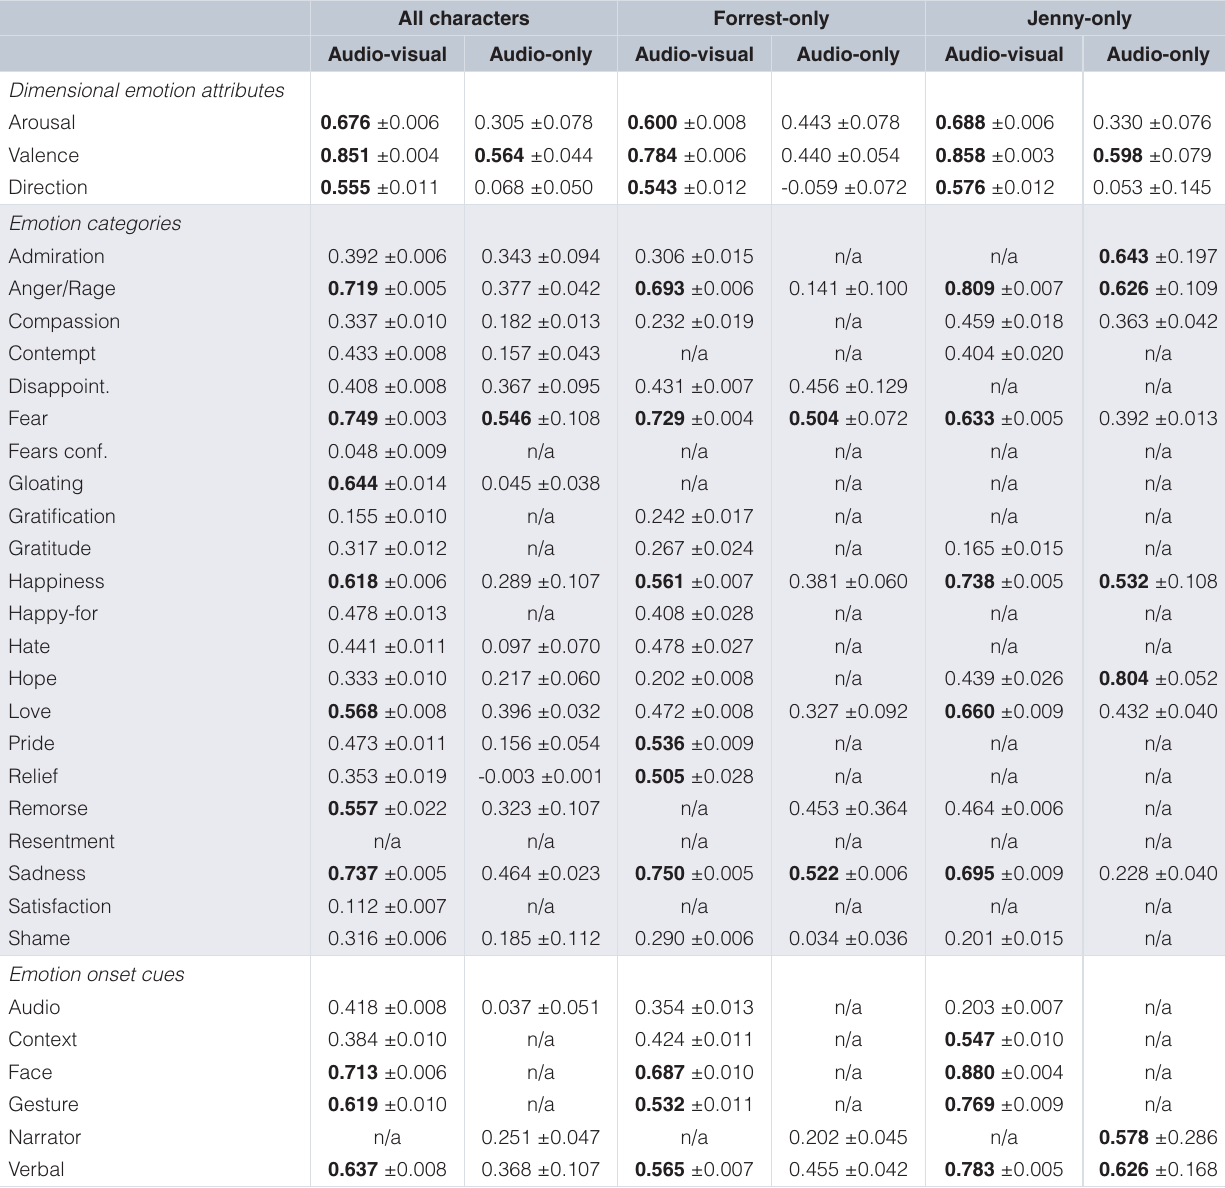
Table 5. Intra-stimulus inter-observer consistency. All values are Spearman correlations for 1 Hz modulations of the fraction of IOA (as, for example, depicted in figure 3) with respect to a particular emotion attribute across the entire duration of the movie. The specified range corresponds to the width of the 95% confidence interval of the mean correlation for all possible combinations of partitioning observers into two sub-groups (audio-visual 4 vs. 5; audio-only 1 vs. 2). Higher correlations indicate higher consistency of agreement modulations across observer sub-groups. Correlations higher than 0.5 (arbitrary threshold) are depicted in bold for visualization purposes. The all characters column indicates the agreement for a particular emotion attribute over time irrespective of the annotated character. The columns on